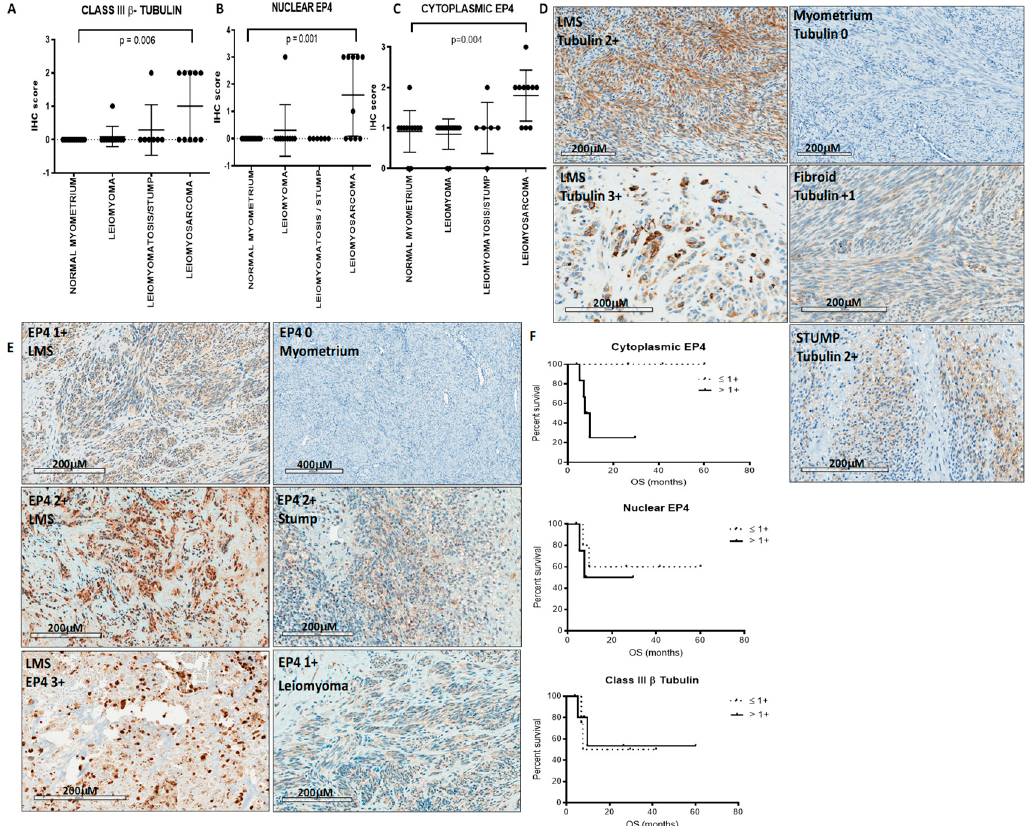
Figure 3. Protein expression in solid tissues. ( A ) Leiomyosarcoma overexpressed class III β -tubulin relative to samples of normal myometrium ( p = 0.006), leiomyoma, and leiomyomatosis/STUMP. ( B ) Immunohistochemistry scores for cytoplasmic ( p = 0.001) and ( C ) nuclear ( p = 0.004) EP4 expression were higher in LMS compared to normal myometrium and other smooth muscle tumors. ( D , E ) Representative immunohistochemistry staining for tubulin and EP4 in normal myometrium and uterine stromal tumors. ( F ) Survival analysis of >1+ cytoplasmic EP4 expression suggests a trend for poorer overall survival (top). Differences in overall survival were not observed in nuclear EP4 expression (middle) or in class III β -tubulin expression (bottom); however due to insufficient events from the small number of cases statistical analysis of survival cannot be performed.